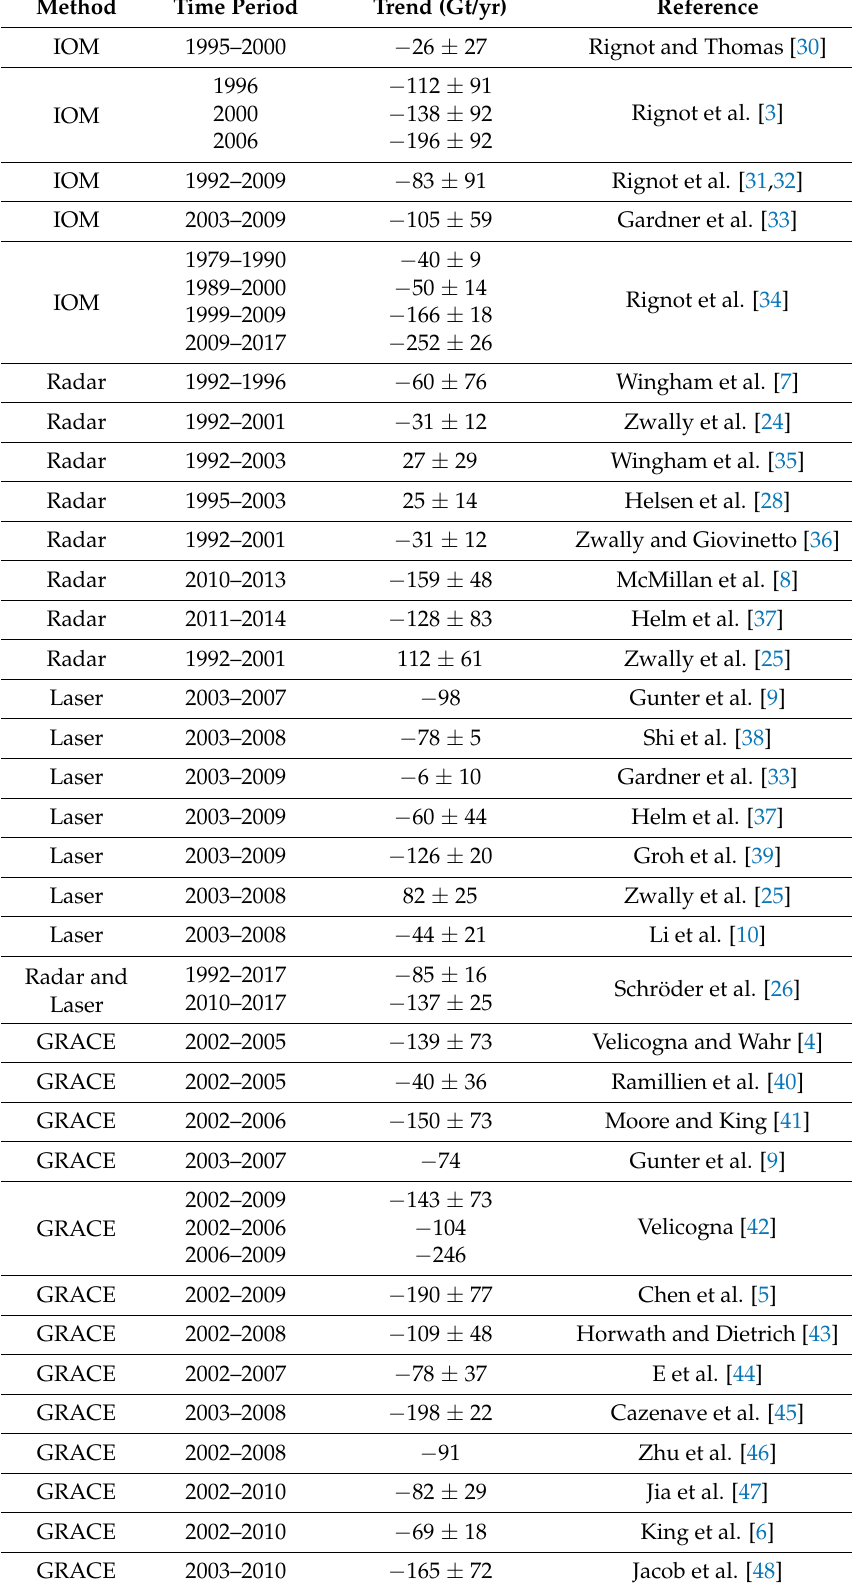
Table 1. The trends of mass change over the Antarctic ice sheet (AIS) published in the last two decades.